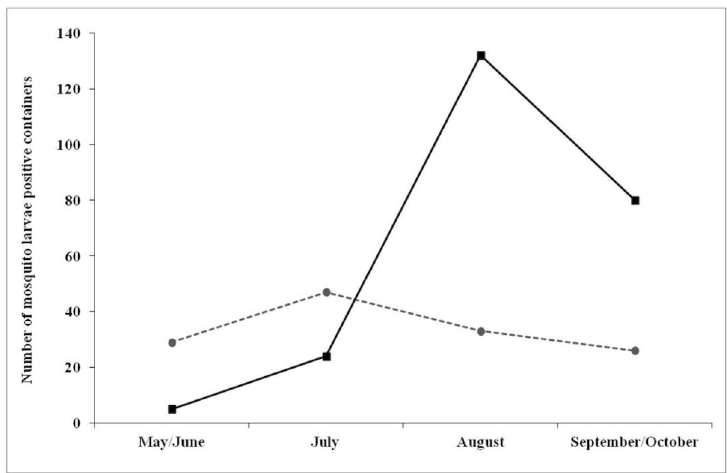
Figure 4. Seasonal shift in the number of containers positive for Ae . albopictus (black line) and Cx. pipiens (grey dashed line) during the larval surveys. Time stage 1 = May/June, 2 = July, 3 = August, 4 = September/October. doi: